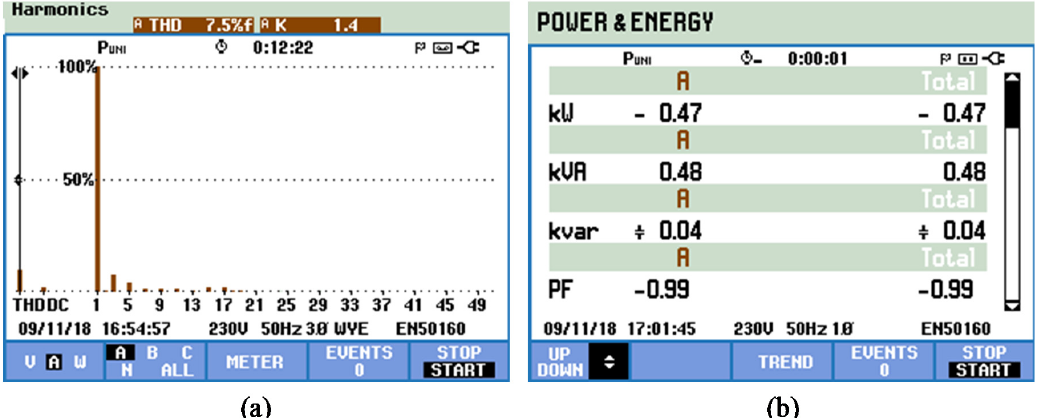
Figure 17. Experimental results during the MF-EVCS operation in R2G mode combined with V2G